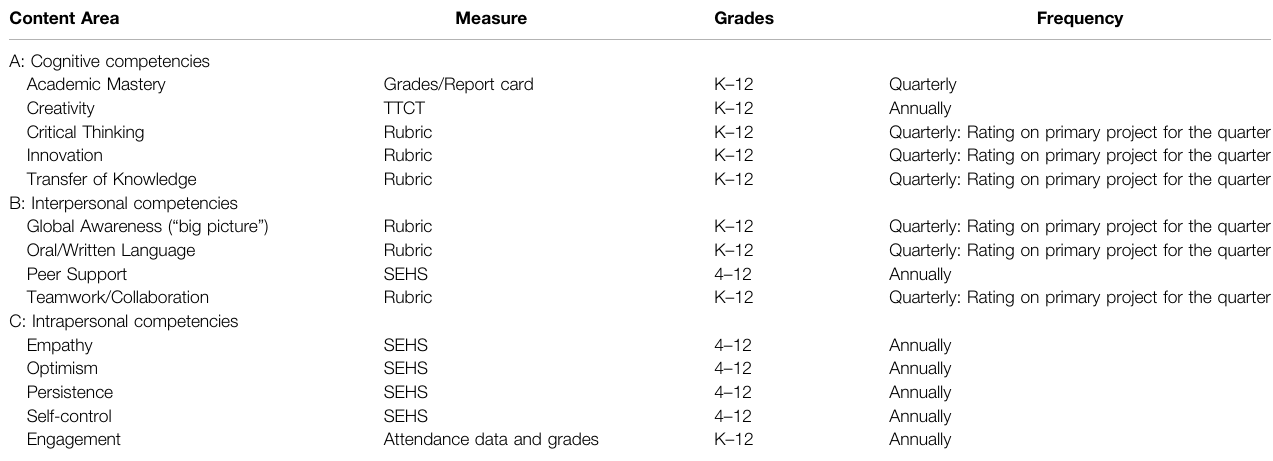
TABLE 1 | 21st-century skill